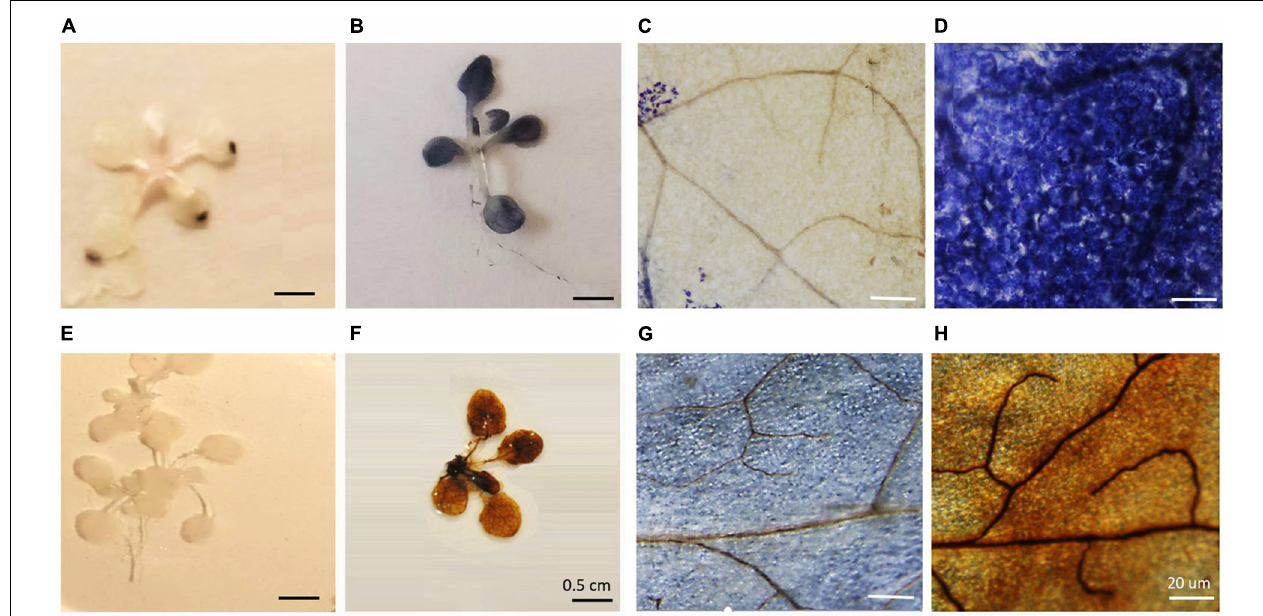
FIGURE 1 | The effects of heat stress on nitrobluetetrazolium (A–D) and 3,3 (cid:48) –diaminobenzidine (E–H) staining of leaves.